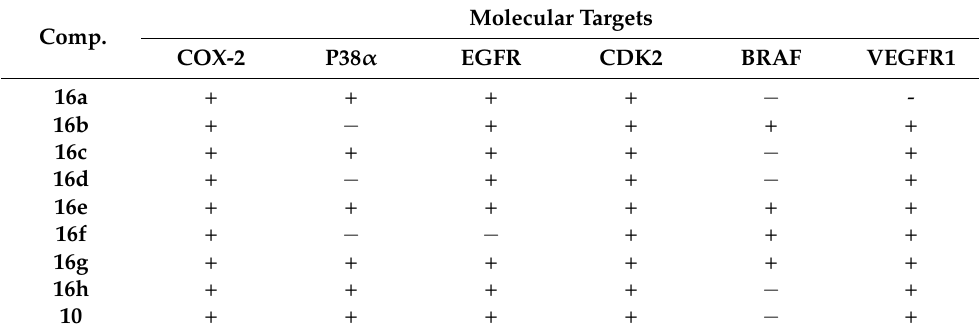
Table 4. Potential targets of compounds 16 a – h based on the results of SwissTargetPrediction.